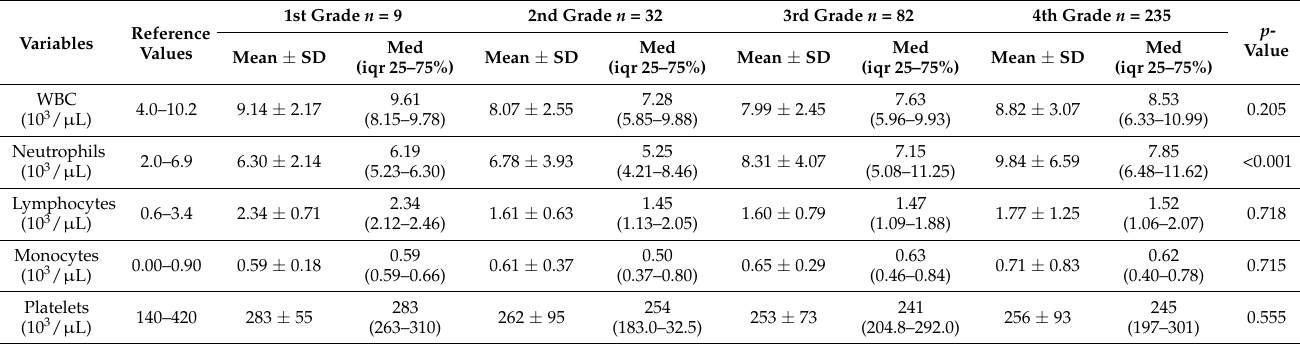
Table 2. White blood cells and platelets counts ( n =